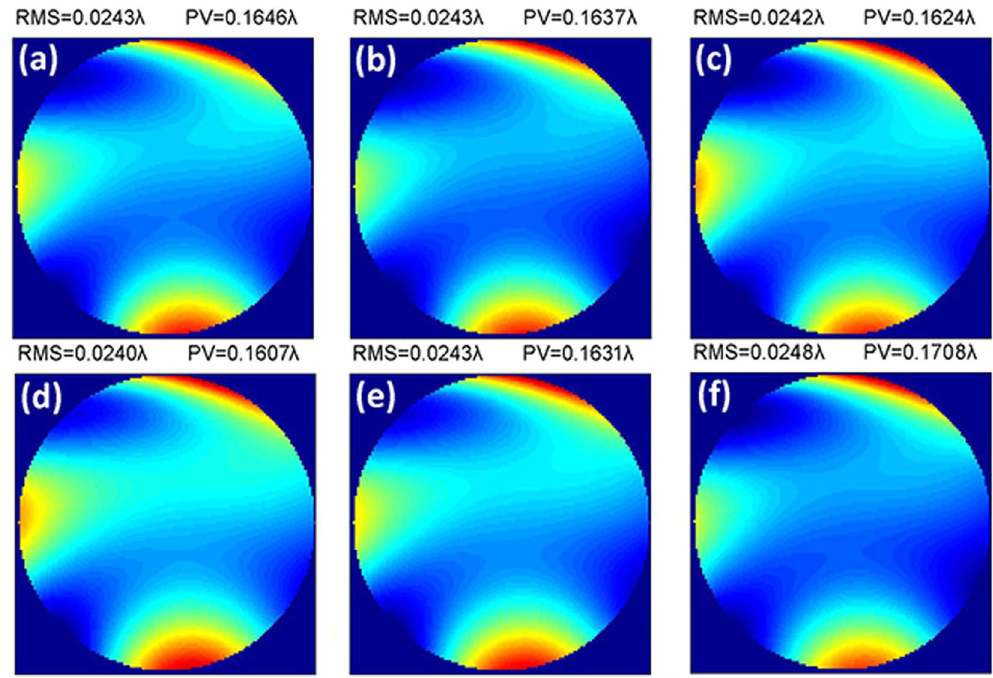
Figure 4. The WFE map for the optical system in fields of (0.3° + 1 ′ , 0.7°), (0.3° − 1 ′ , 0.7°), (0.3°, 0.7° + 1 ′ ),